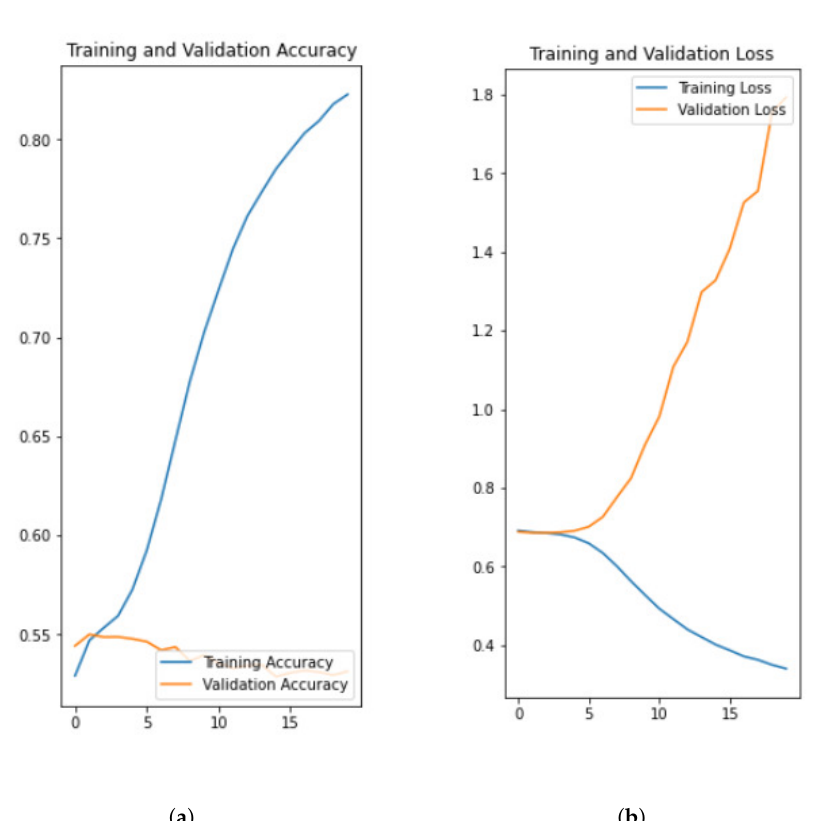
Figure 13. The accuracy and loss function for convolutional neural networks. The overfitting is quickly reached after few iterations. ( a ) Accuracy; ( b ) loss function.